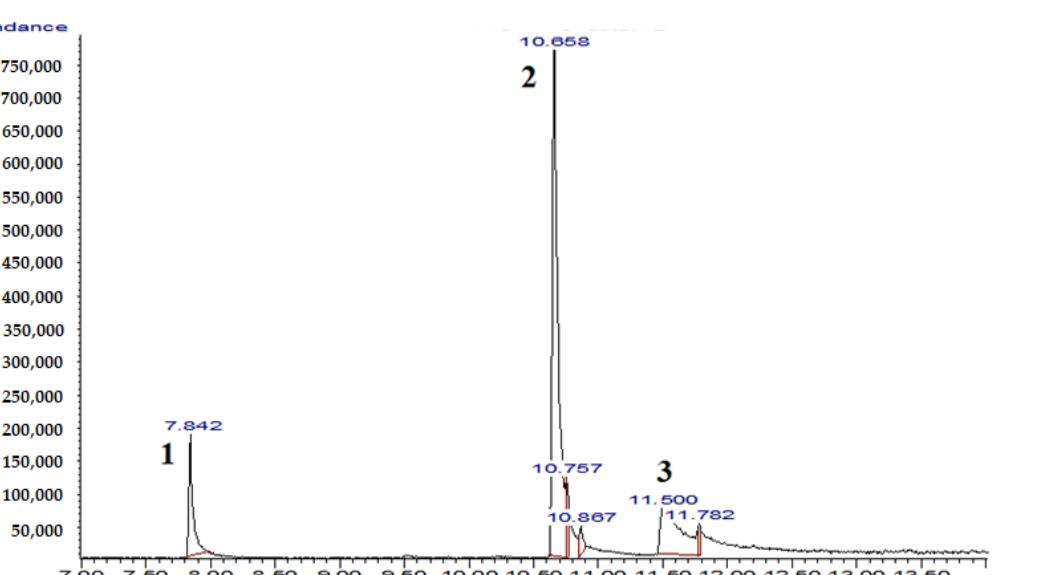
Figure 7. TLC of (–)-isopulegol ( a ) Rf 0.65 and its biotransformation products; ( b ) Rf 0.01 and 0.07 using R . rhodochrous IEGM 1362 cells.